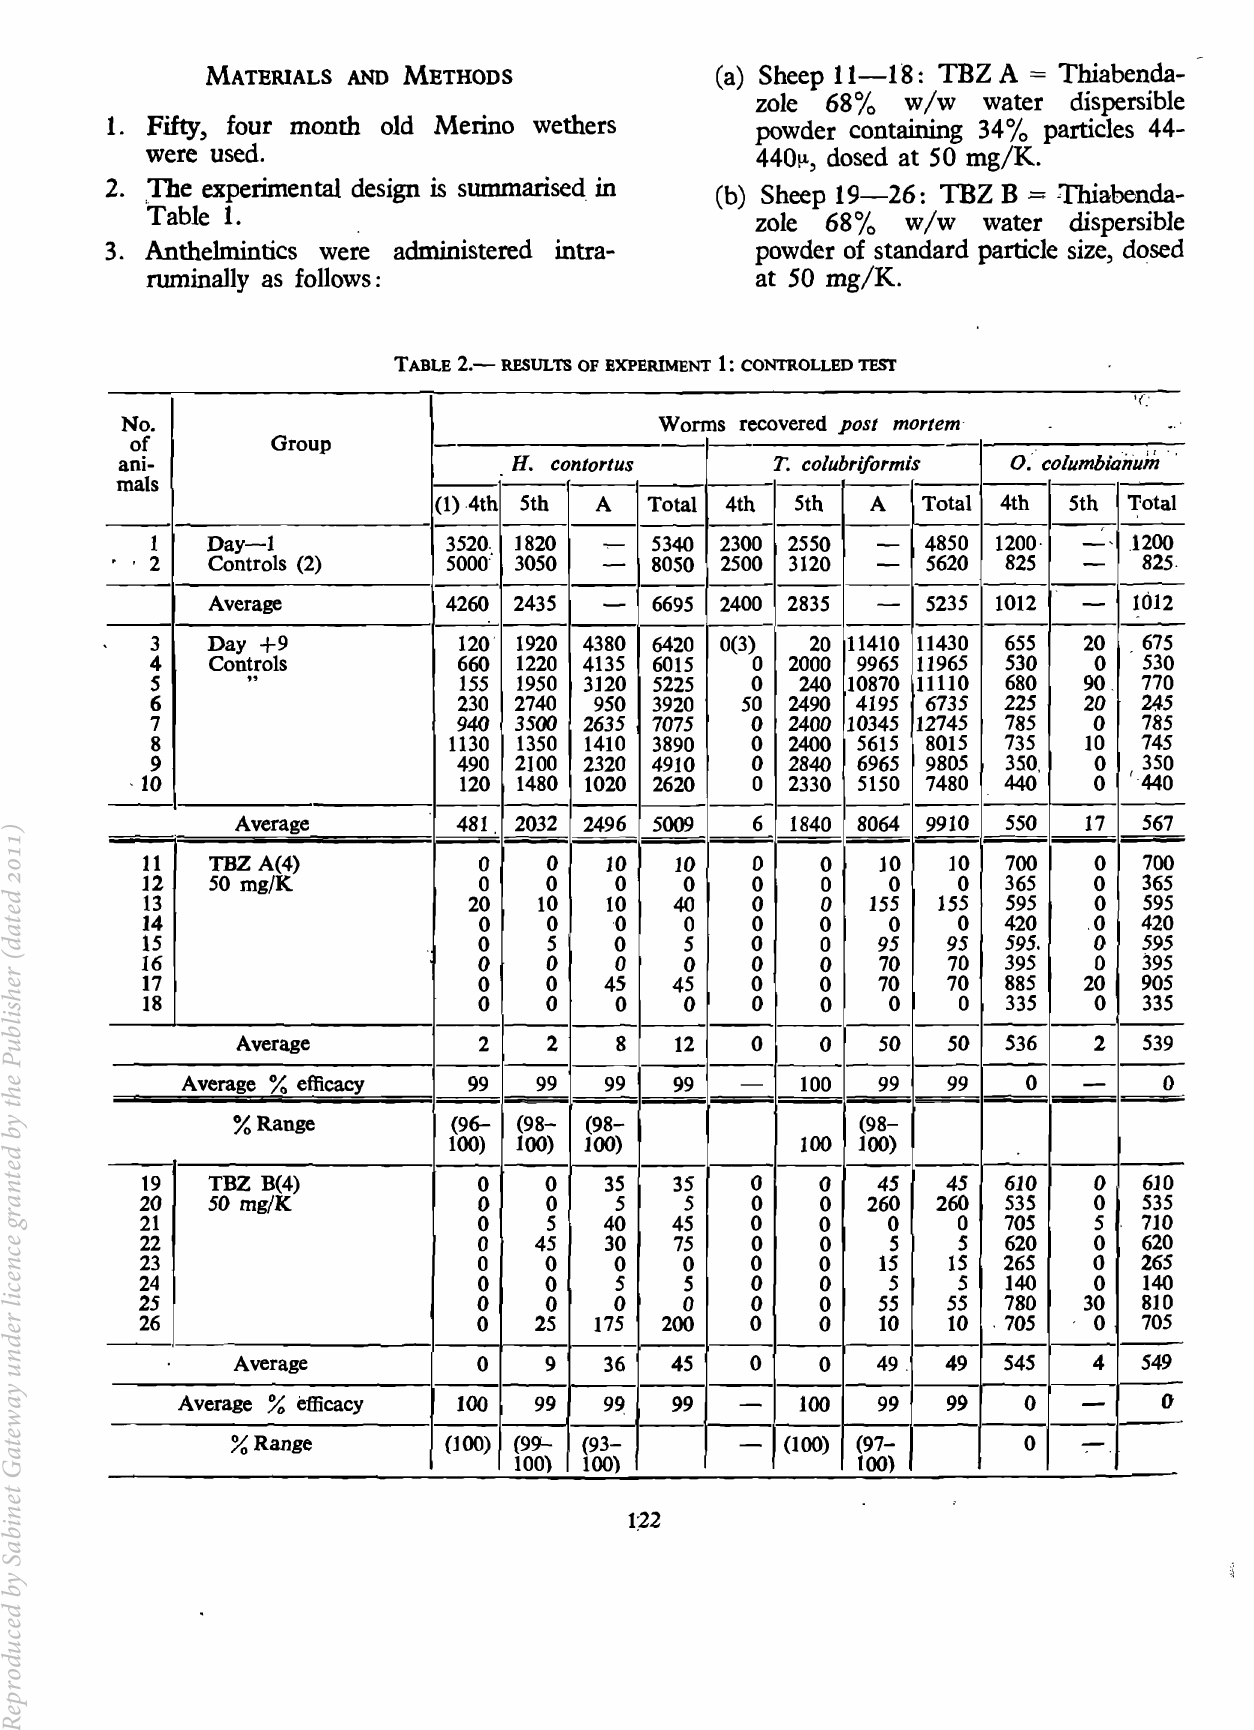
TABLE 2.- RESULTS OF EXPERIMENT 1: CONTROLLED